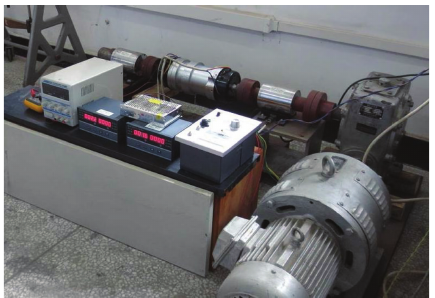
Figure 6: Test system of MR transmission performance.